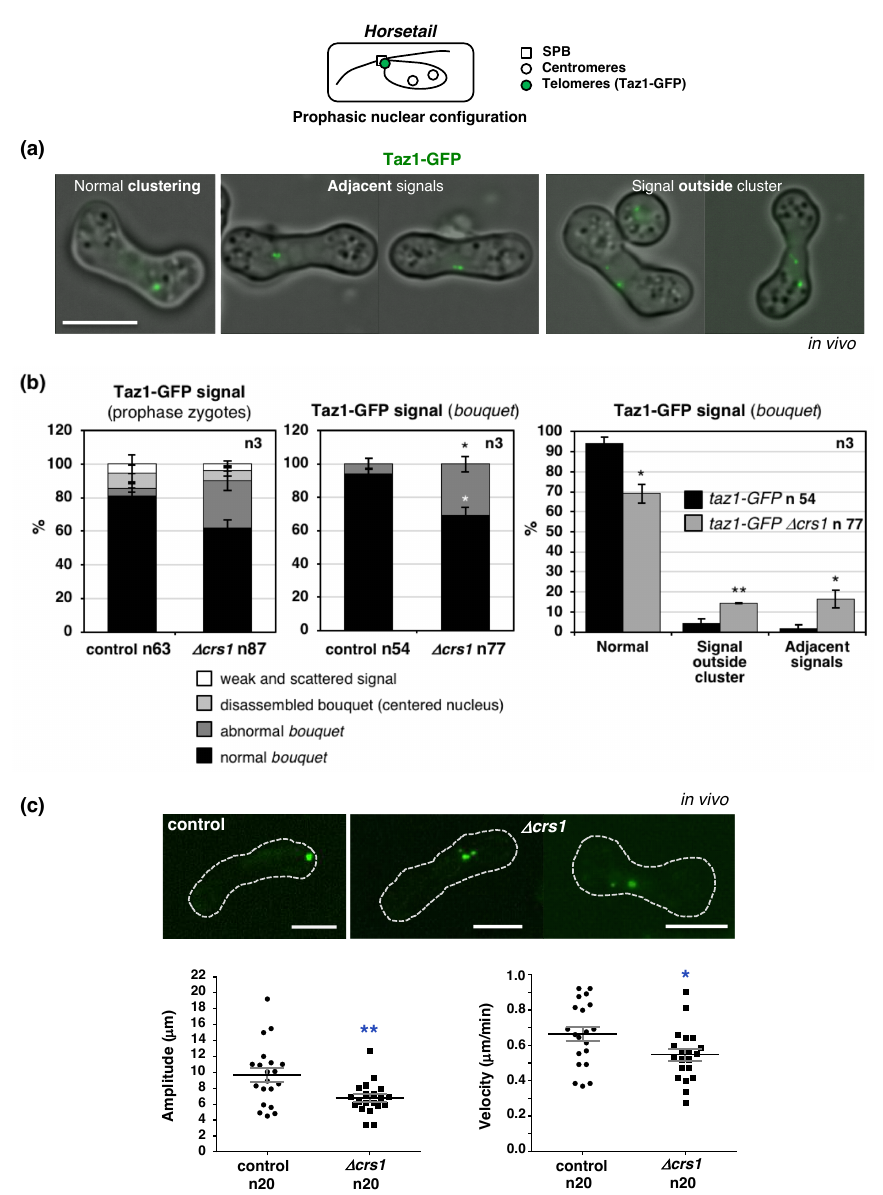
Figure 7. Bouquet formation and nuclear movement in crs1 deletion mutants. Top panel: Schematic drawing of SPB, centromeres, and telomeres position during meiotic prophase is shown. ( a ) In vivo Taz1-GFP (telomeres) localization in prophase in h 90 wild-type (CMC1276) and crs1 mutant (CMC1274) zygotes. Single plane bright-field images are overlapped to single plane Taz1-GFP images. Examples of zygotes with normal bouquet organization (normal Taz1-GFP clustering) and abnormal bouquet organization (adjacent Taz1-GFP signals and Taz1-GFP signals outside of the main cluster) are shown. ( b ) Left graph: Quantification of Taz1-GFP organization in wild-type and crs1 deletion mutants. Data are the mean of the percentage of each category +/ − SEM of three independent experiments with a total of 63 control and 87 crs1 zygotes analyzed. In addition to “normal bouquet ” and “abnormal bouquet ” categories described in ( a ), similar low percentages of zygotes were observed in wild-type and crs1 mutants with disassembled bouquets (centered rounded-nuclei with intense scattered Taz1-GFP signal), and very weak and scattered signal in more elongated nuclei. Middle graph: Quantification of bouquet organization (normal and abnormal categories) in the same experiments. Fifty-four control and 77 crs1 zygotes analyzed. Right graph: Quantification of bouquet defects in wild-type and crs1 deletion mutants in the same experiments. ( c ) Top images: Examples of cluster disorganization in crs1 mutants (frames from time lapse experiments shown in Figures S3–S5). Bottom graphs: Quantification of the amplitude and velocity of nuclear movements in wild-type and crs1 deletion mutants by Taz1-GFP tracking. Individual data are plotted, and the mean +/ − SEM is indicated. Pooled data of two independent experiments with a total of 20 control and 20 crs1 zygotes analyzed. p value * < 0.05, ** ≤ 0.01 (Student’s t -test, unpaired, two tails). Scale bar corresponds to 5 µ m in all the images in the